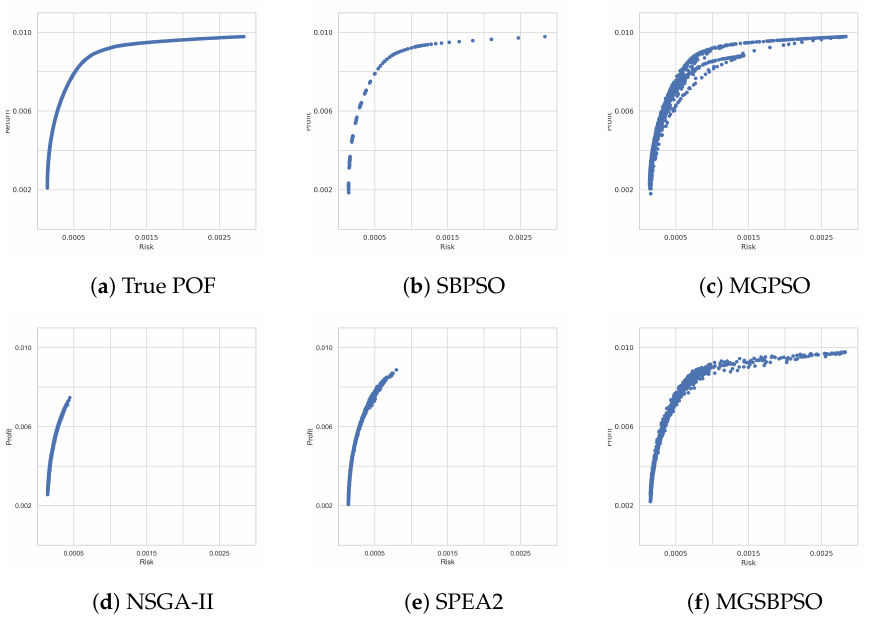
Figure 4. Obtained Pareto-optimal fronts for DAX 100.